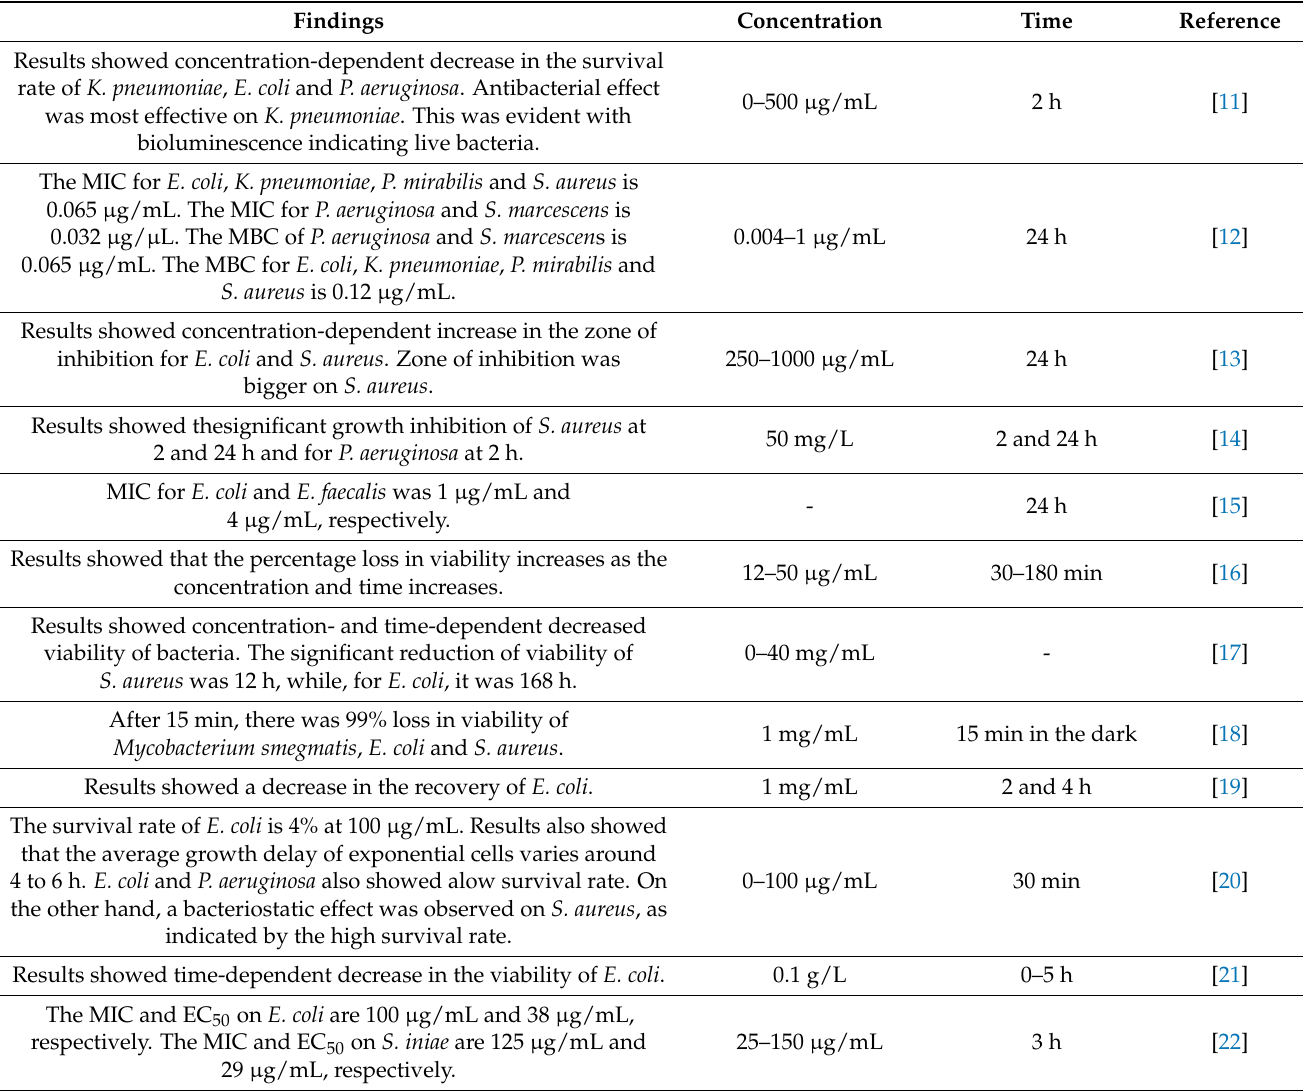
Table 1. Antibacterial activity of GO reported as time and concentration-dependent.